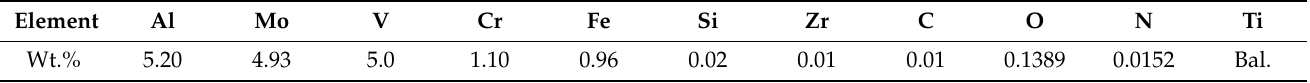
Table 2. Chemical composition of the Ti-55511 powder used in this